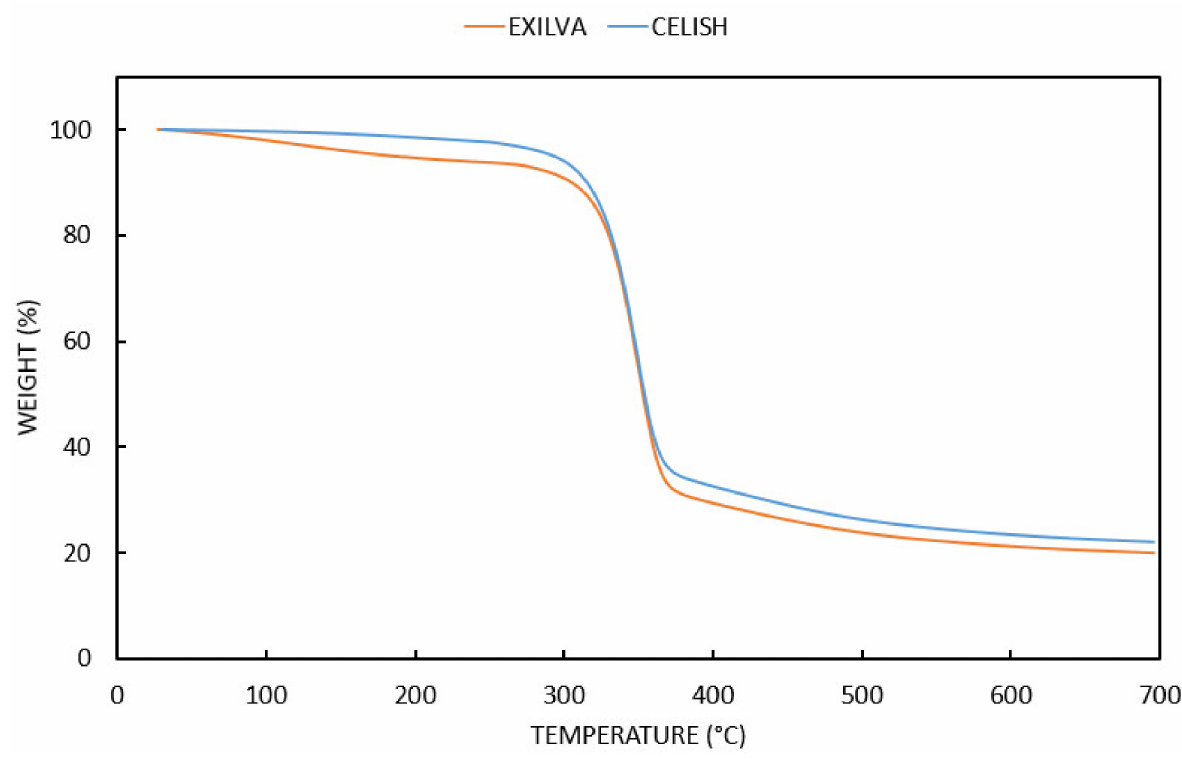
Figure 2. Thermogravimetric analysis (TGA) thermograms of Exilva F 01-L and Celish KY100S.